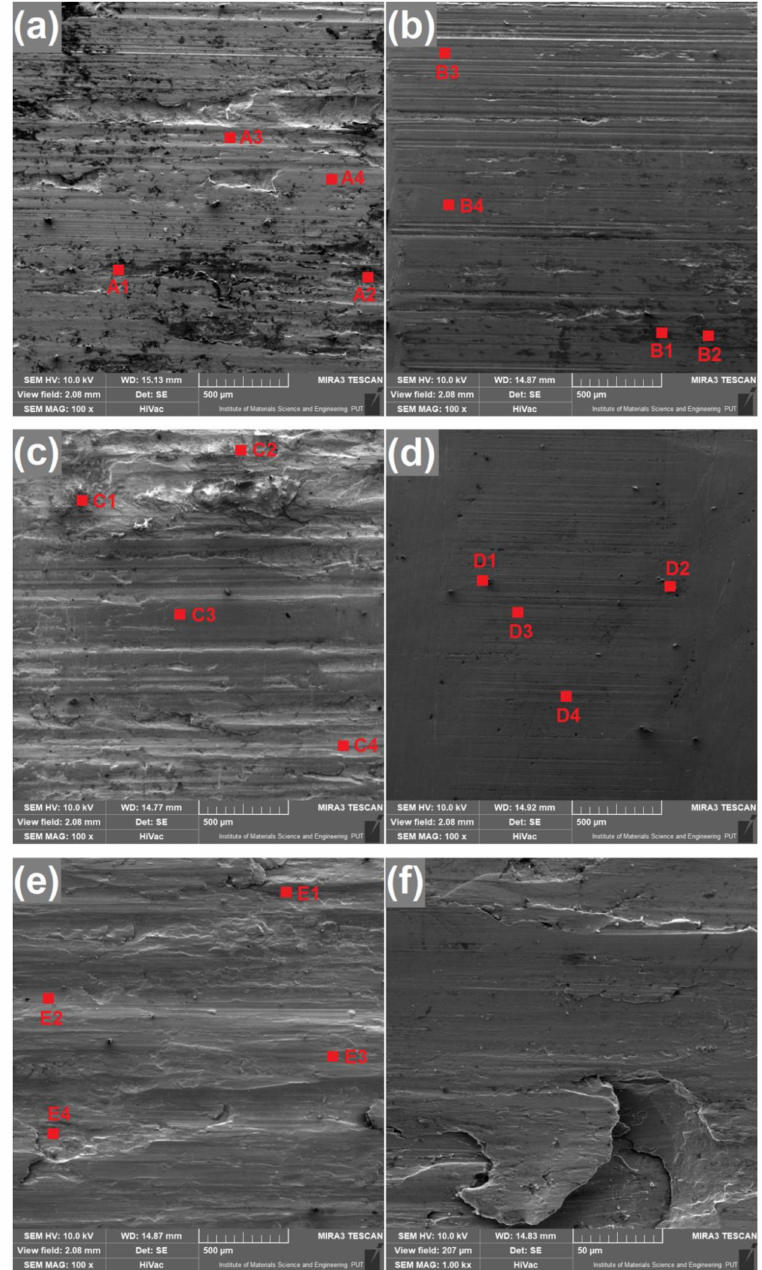
Figure 8. Surfaces after the wear test of specimens produced with: ( a ) v l = 5 m / min and t b = 100 µ m, ( b ) v l = 5 m / min and t b = 200 µ m, ( c ) v l = 50 m / min and t b = 100 µ m, ( d ) v l = 50 m / min and t b = 200 µ m, ( e , f ) untreated Monel